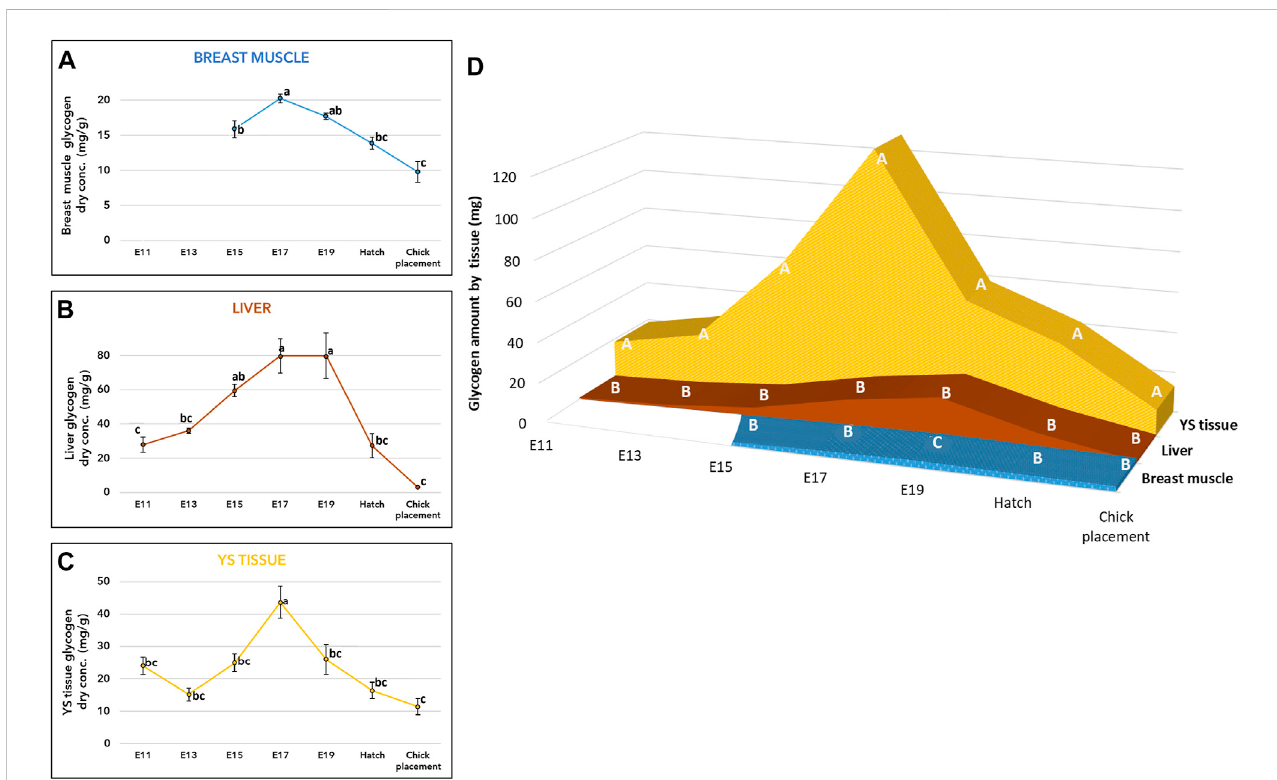
FIGURE 2 Glycogen levels from E11 until hatch and at chick placement (A – C) Dry weight concentration (mg/g) and (D) total tissue amount (mg) of YS tissue, liver, and breast muscle (A – C) The lower-case letters denote for means signi fi cantly different between days within each organ, as derived from a one-way ANOVA Tukey ’ s HSD test (D) The capital letters denote for means signi fi cantly different between organs within each day as derived from a two-way ANOVA followed by Tukey ’ s HSD test. ( p ≤ 0.05), n = 6 per day.